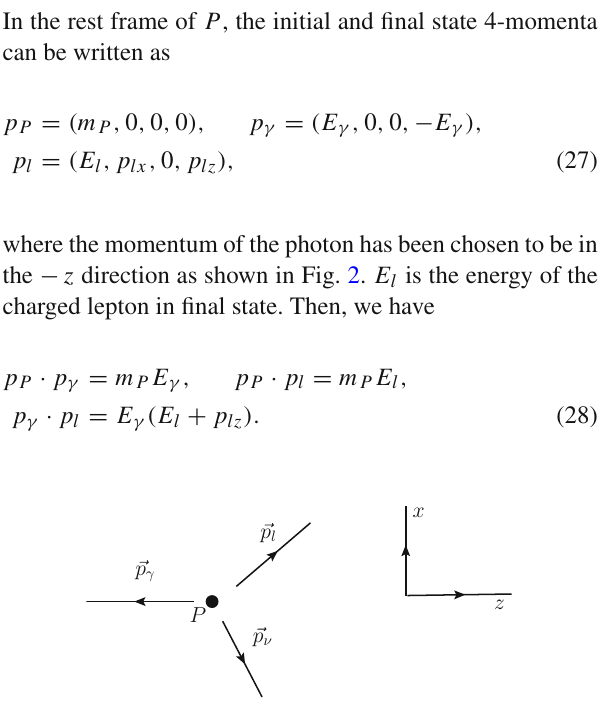
Fig. 2 The sketch for kinematics of the radiative leptonic decays of charged B and D